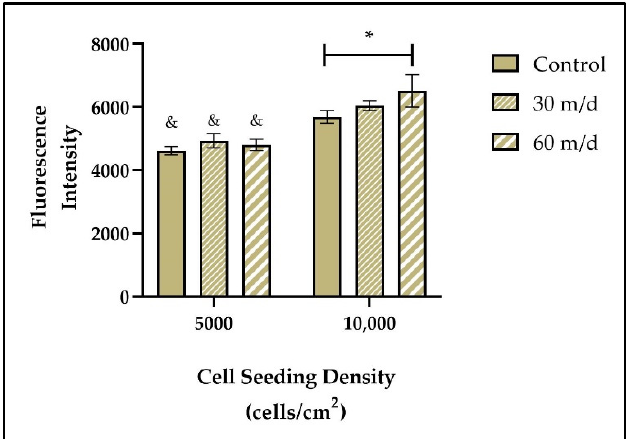
Figure 2. Alamar Blue metabolic activity assay results for Y201 cells seeded at 5000, or 10,000 cells/cm 2 on day 5 in either unstimulated (control) conditions, or under ES of 30 or 60 min per day (m/d). * p < 0.05 versus unstimulated control cells seeded at 10,000 cells/cm 2 ; & p < 0.05 versus all three 10,000 cells/cm 2 groups. N = 3 for controls, and N = 5 for ES groups. Statistical analysis per- formed by a two-way ANOVA, and Tukey’s multiple comparisons test.